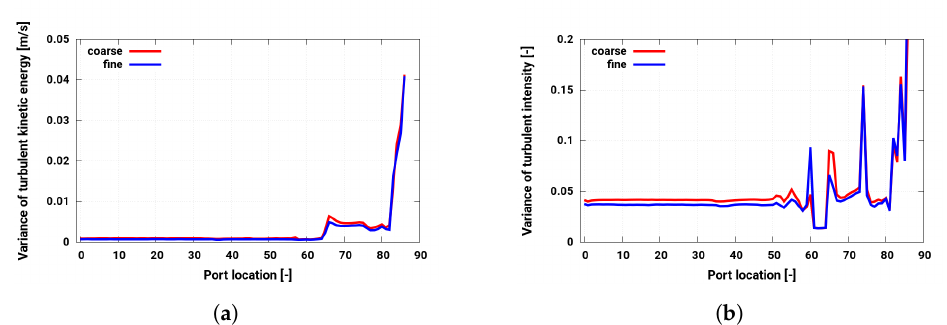
Figure 18. Evolution of variance of turbulence properties along the intake duct: ( a ) variance of turbulent kinetic energy, ( b ) turbulence intensity.